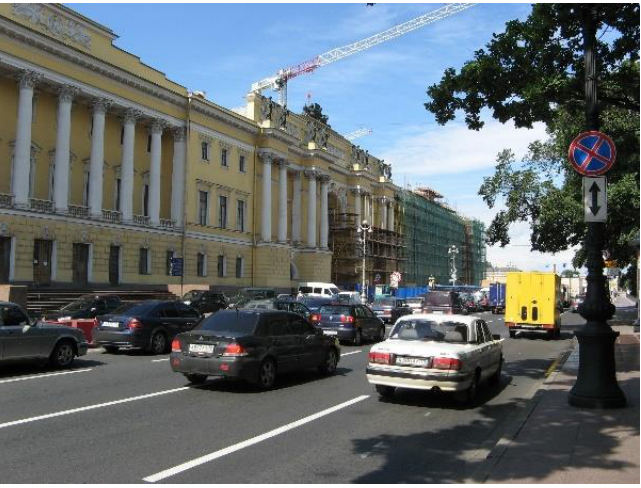
Figure 26. Historical Russian Senate building during the time of restoration.